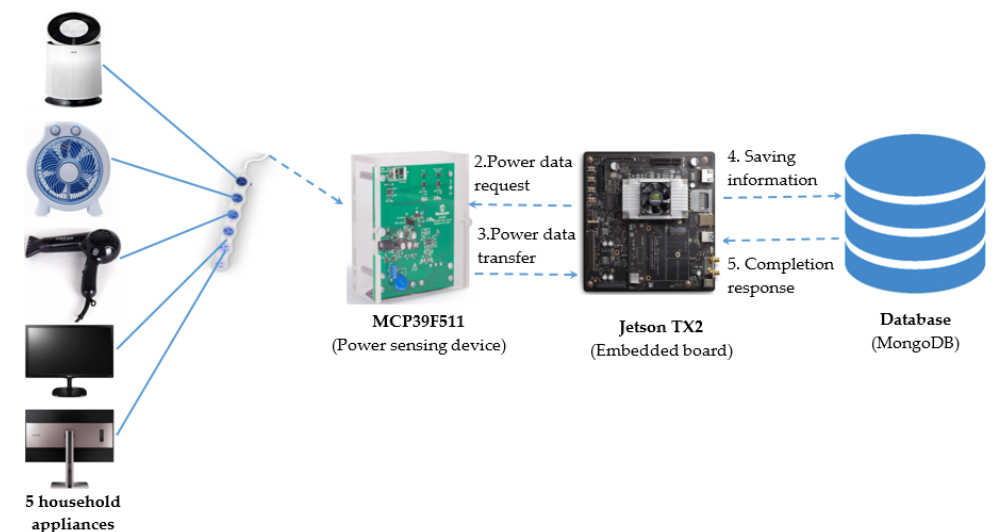
Figure 6. System configuration diagram collection data.